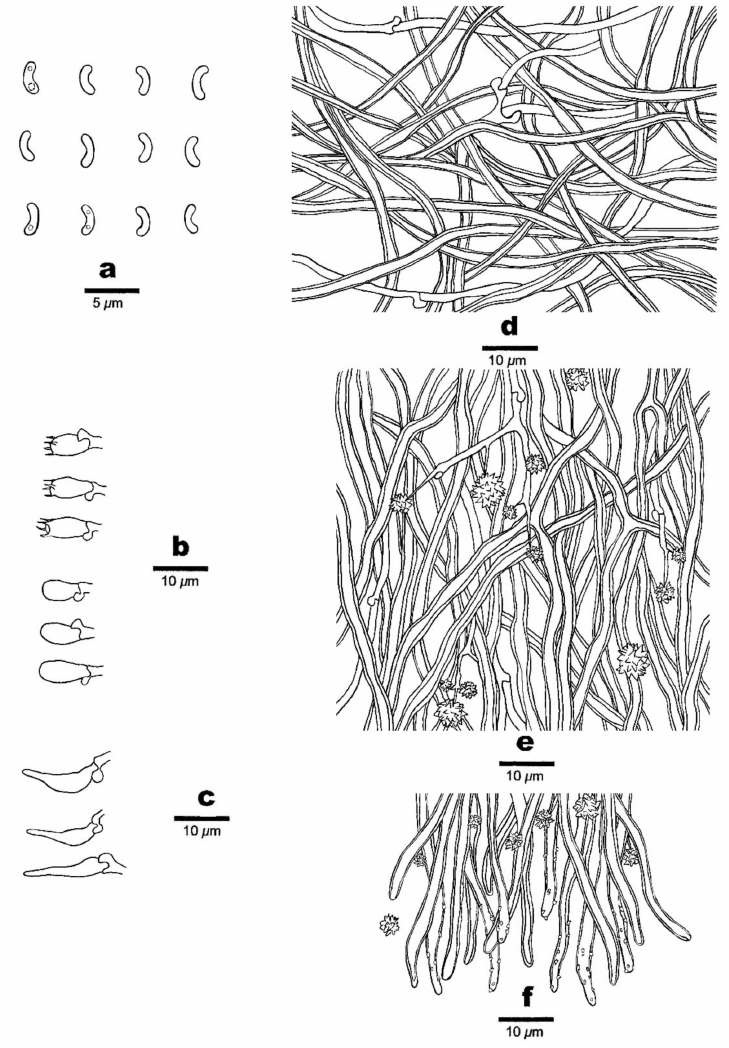
Figure 5. Microscopic structures of Sidera inflata (holotype, Cui 13610). ( a ) Basidiospores. ( b ) Basidia and basidioles. ( c ) Cystidioles. ( d ) Hyphae from subiculum. ( e ) Hyphae from trama. ( f ) Hyphae at dissepiment edge. Drawing by Meng